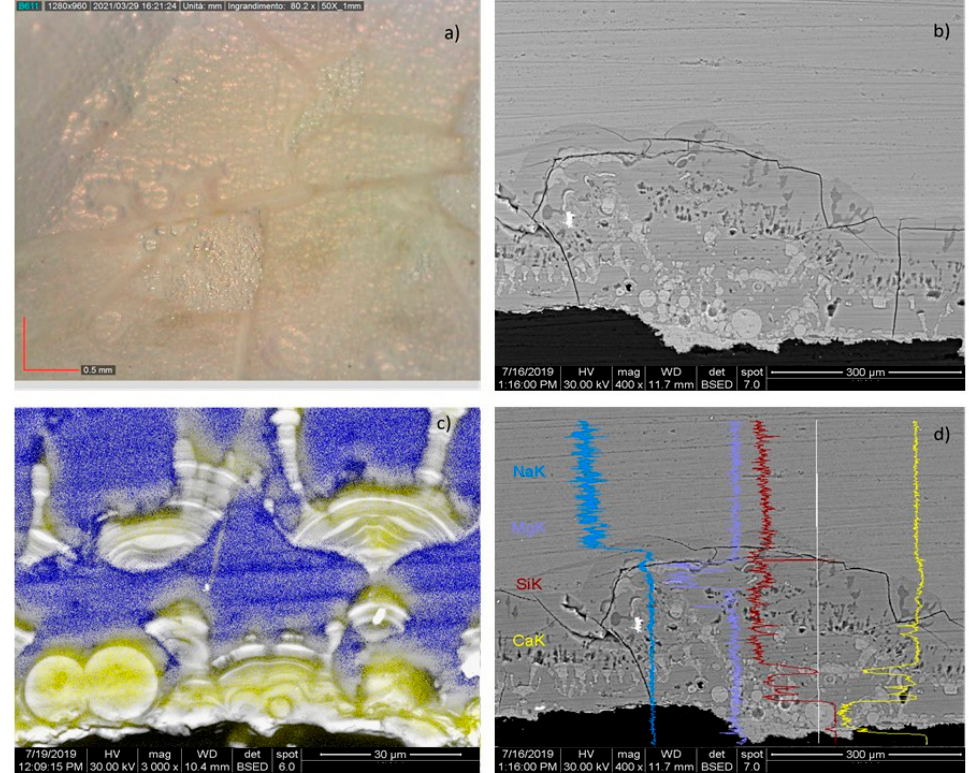
Figure 5. Sample KK_d11: ( a ) OM documentation; ( b ) BSE image of the cross-section, with detail of the alteration layer; ( c ) SEM-EDS mapping, with details of Ca (yellow) and Si (blue) contents; ( d ) EDS line scan through the altered surface and the pristine glass.